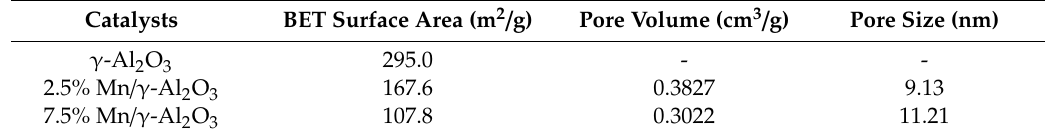
Table 2. Brunauer-Emmet-Teller (BET) surface areas of γ -Al 2 O 3 , 2.5% and 7.5% Mn / γ -Al 2 O 3 catalysts.